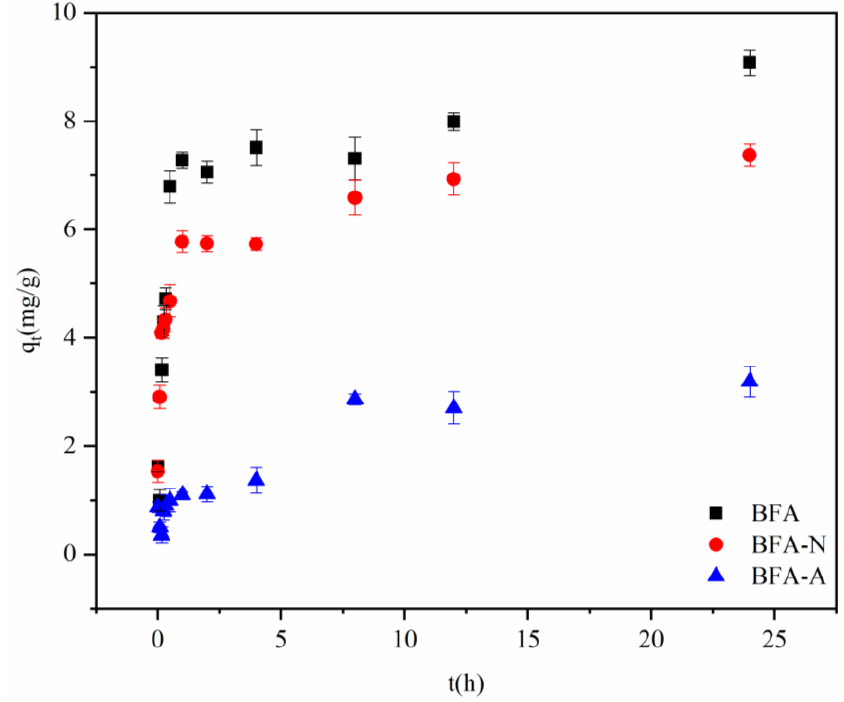
Figure 6. Absorption kinetic curves of Cd by BFA, BFA-N, and BFA-A. Pseudo-first-order kinetic model and pseudo-second-order kinetic model were used